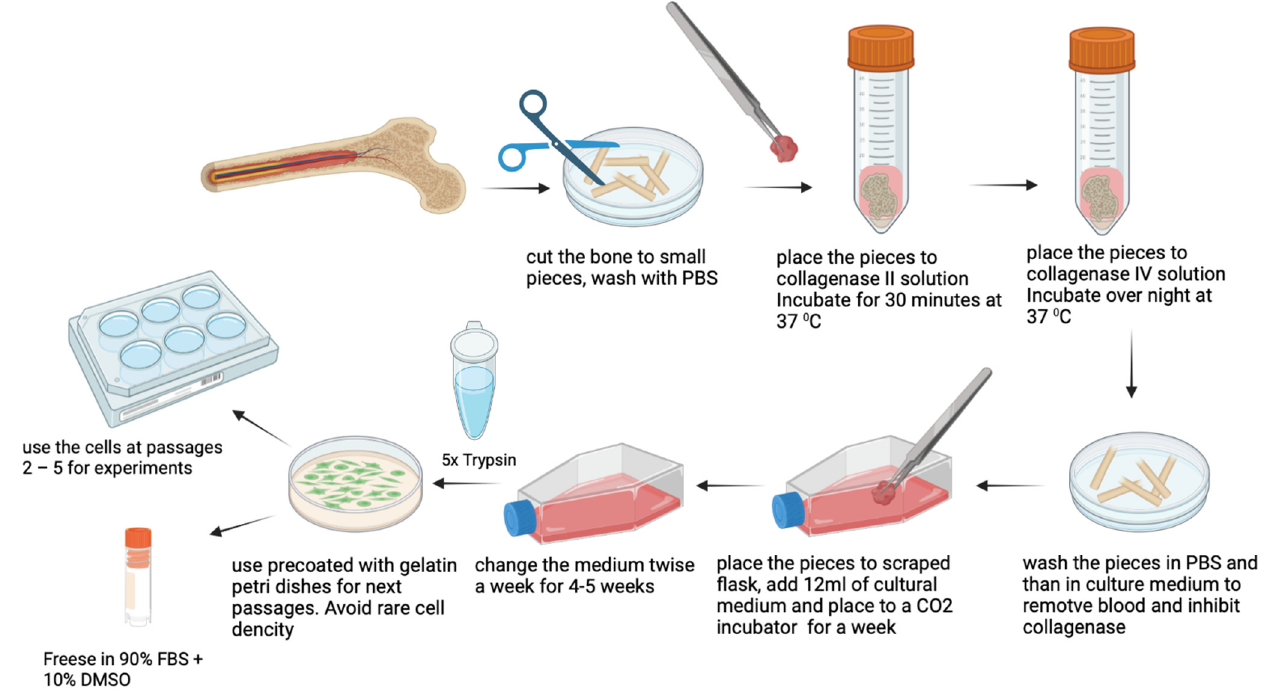
Figure 1. Schematic representation outlining the necessary steps for the isolation, maintenance, characterization, and cryopreservation of the OB